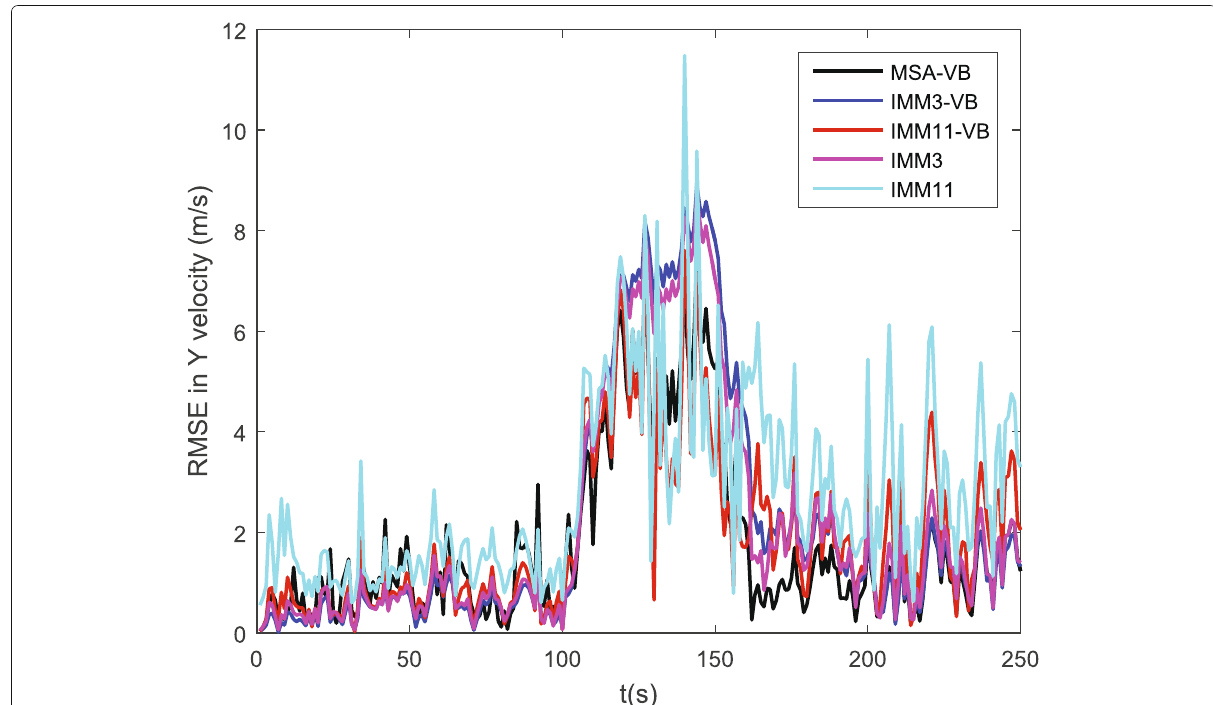
Fig. 9 RMSEs in Y velocity of the proposed algorithm, IMM3, IMM11, IMM3-VB, and IMM11-VB in scenario 2